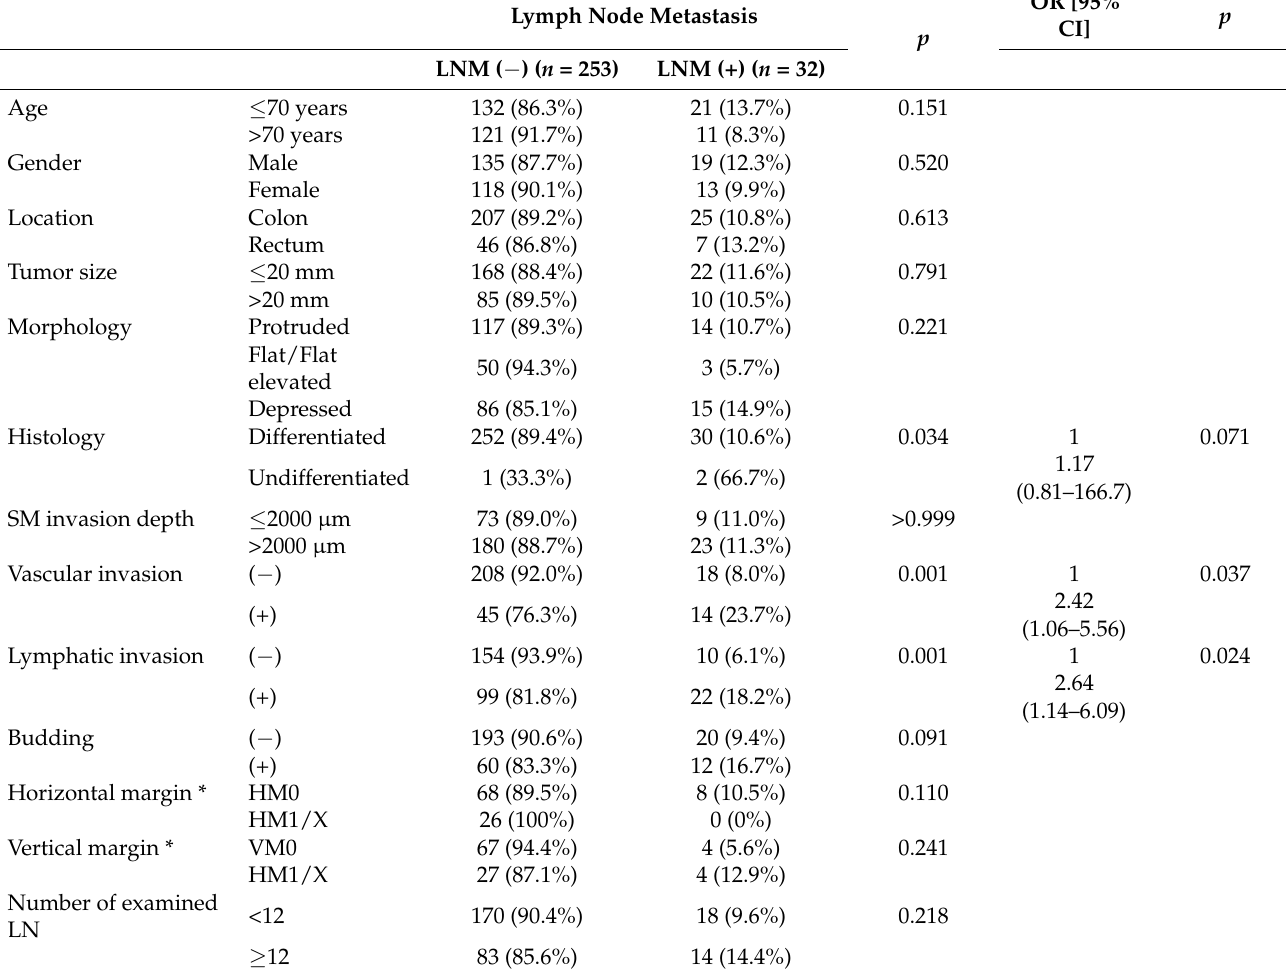
Table 2. Risk factors for lymph node metastasis in the high-risk group. Lymph Node